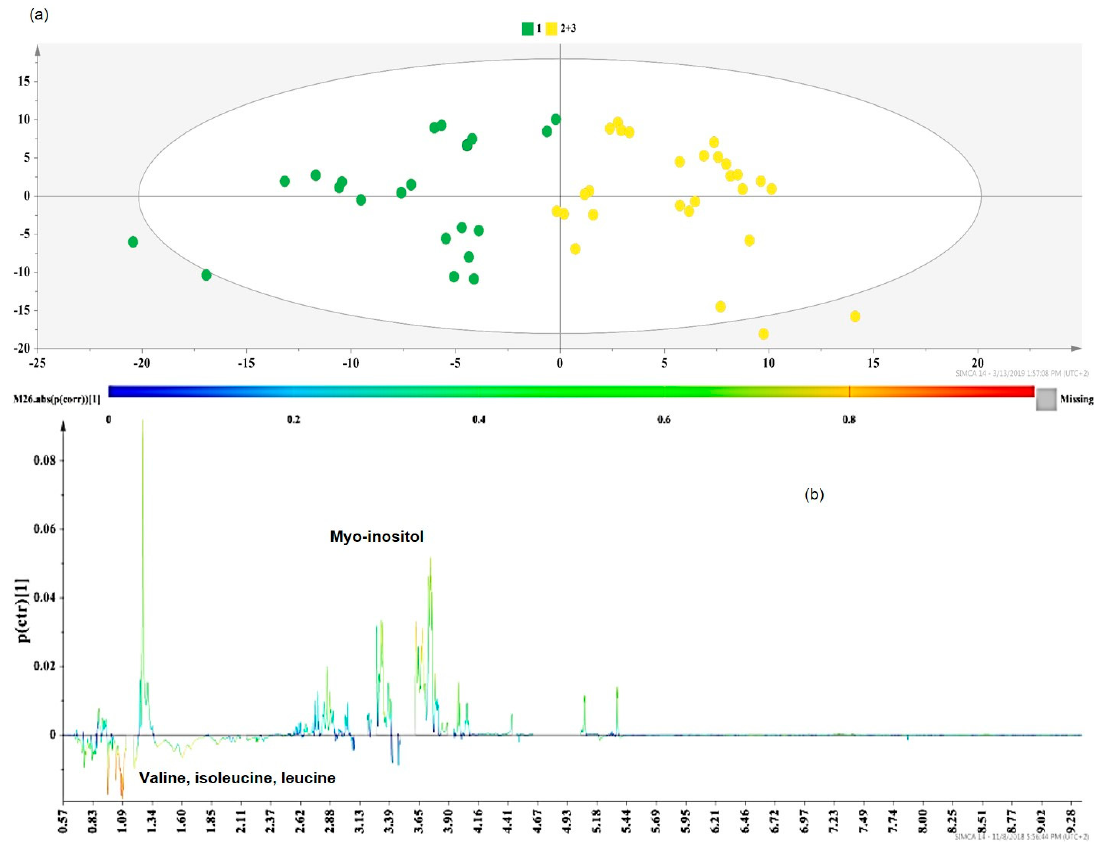
Figure 8. ( a ) Orthogonal Projections to Latent Structures Discriminant Analysis (OPLS-DA) model of Group 1 vs. Group 2+3 DOE apricot extracts, Pareto scaled, where A = 1 + 1 + 0 (N = 48, R 2 Y(cum) = 0.706, Q 2 (cum) = 0.596, p < 0.05), green dots = apricot pulp samples with a low extraction yield ( ≤ 5 mg carotenoids 100 g − 1 dry sample), and yellow dots = apricot pulp samples with a higher extraction yield (between 5 and more than 20 mg carotenoids 100 g − 1 dry sample); ( b ) S-line plot of the OPLS-DA model.